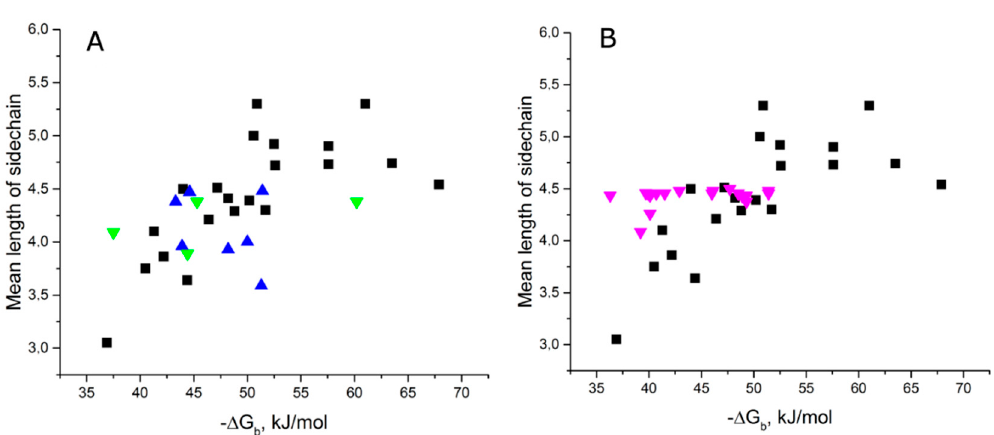
Figure 4. Comparison of aptamer–protein and DNA helix–protein complexes plotted in the coordinates mean lengths of sidechain of amino acids within 4 Å vicinity of polar contacts versus changes in Gibbs free energy during binding. ( A ) HTH-type proteins from mesophiles with human-like conditions (blue dots), and other organisms (Bacillus and a thermophile = green dots) were plotted with aptamer–protein complexes (black dots). ( B ) Complexes of fis protein with optimal and non-optimal DNA helices (magenta dots) were plotted with aptamer–protein complexes (black dots).